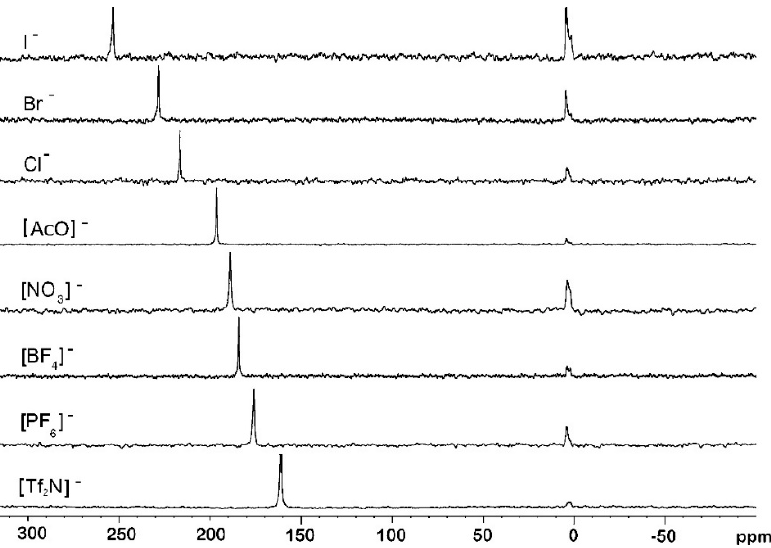
Figure 1. 129 Xe nuclear magnetic resonance (NMR) spectra of xenon dissolved in 1 ‐ butyl ‐ 3 ‐ methylimidazolium ‐ based ionic liquids. The anions are indicated on the left. Reprinted with permission from reference [19]. Copyright 2013 American Chemical Society.